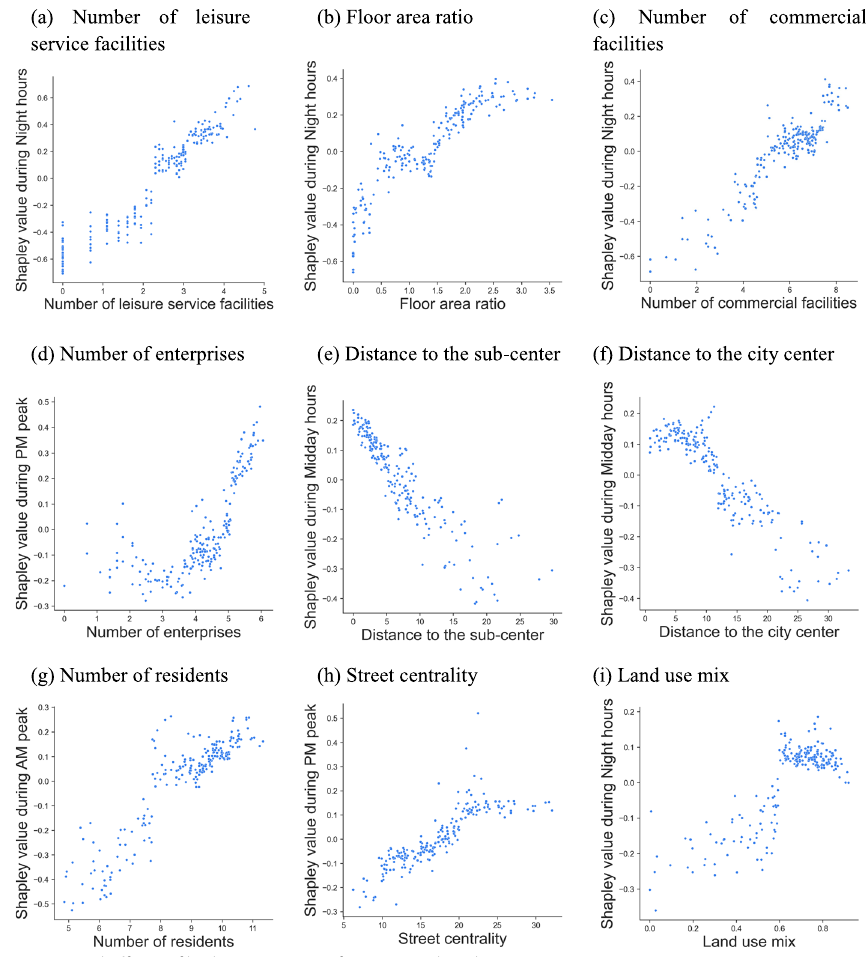
Fig. 5 Local effects of built-environment features on the